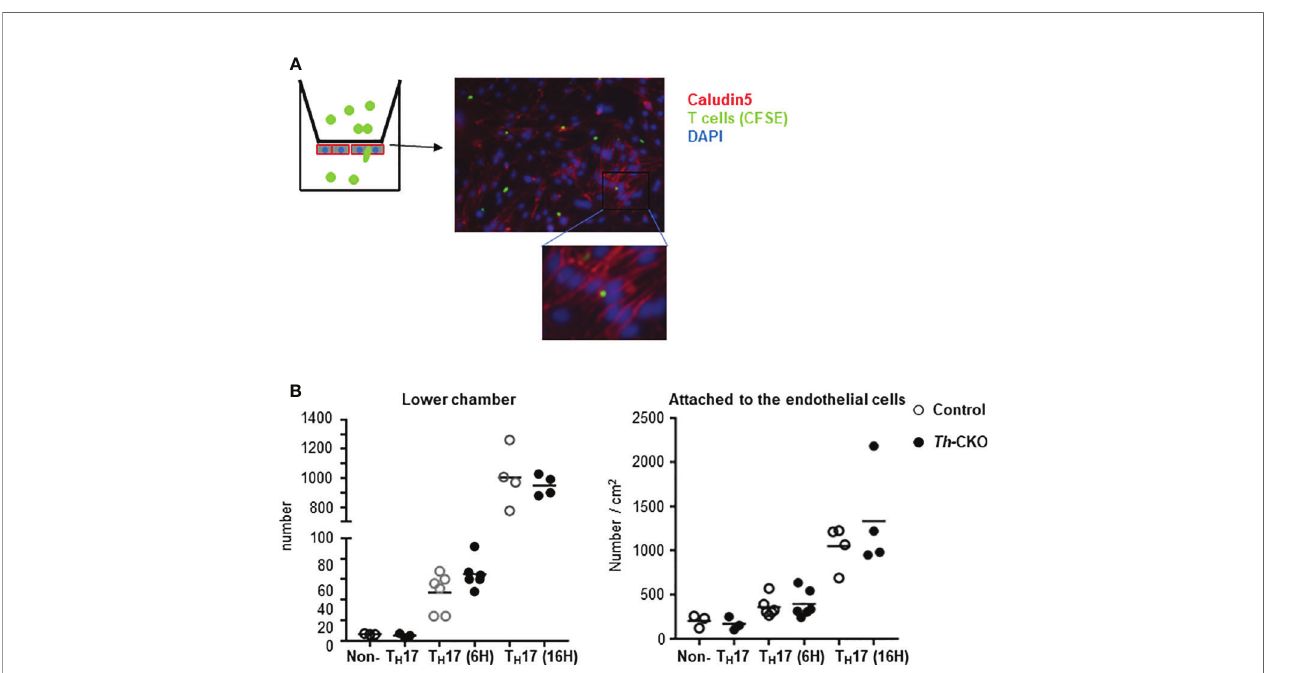
FIGURE 7 | Transmigration of T H 17 cells through brain endothelial cells. (A) Diagram of experiments and a representative image of T cells in the endothelial cells. Brain microvascular endothelial cells are plated on the bottom layer of transwell fi lter. When the cells are con fl uent, CFSE-labeled T cells were loaded in the upper chamber of a transwell apparatus. On day of assay, T H 17 or non-T H 17 cells were isolated from dLNs from day 10 post MOG peptide immunized mice. Transmigrated T cells in the lower chamber were counted and the endothelial cells and T cells were fi xed and stained for Claudin. (B) Number of cells in the lower chamber (graph on the left) and number of cells in the endothelial cells was counted from 5 independent images per sample and normalized to the number per cm 2 (graph on the right). Each dot represents an individual mouse and the bar represents mean (n =